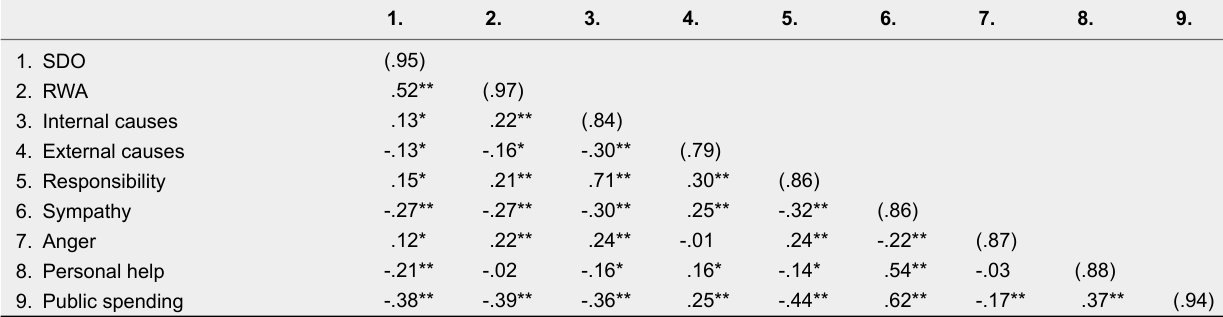
Zero-Order Correlations Between SDO, RWA, and Dependent Measures Across Two